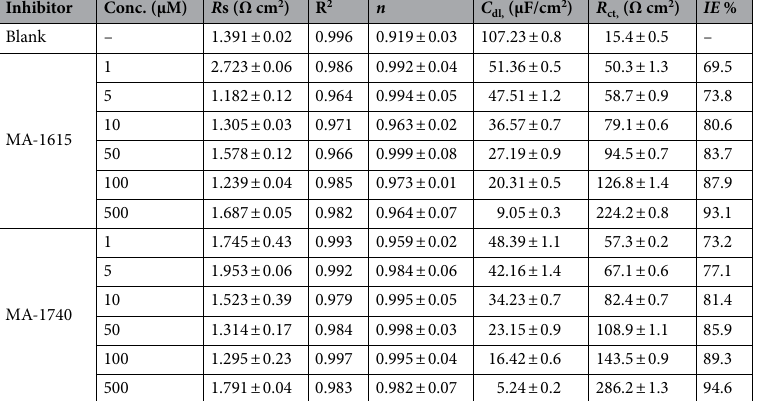
Table 5. Electrochemical parameters obtained from EIS equivalent circuit fitting of the C-steel immersed in 1 M HCl without and with various doses of inhibitor.